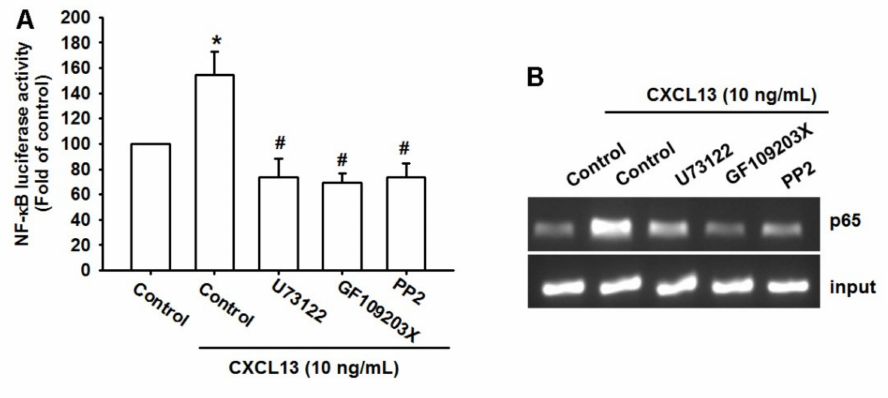
Figure 6. The PLC β , PKC α , and c-Src pathways regulate CXCL13-induced NF- κ B activation. MG-63 cells were pretreated with U73122, GF109203X, or PP2, then stimulated with CXCL13; NF- κ B luciferase activity and p65 binding to the NF- κ B site on the VCAM-1 promoter was examined using the luciferase ( A ) and chromatin immunoprecipitation (ChIP) assays ( B ). * p < 0.05 compared with the control group; # p < 0.05 compared with the CXCL13-treated